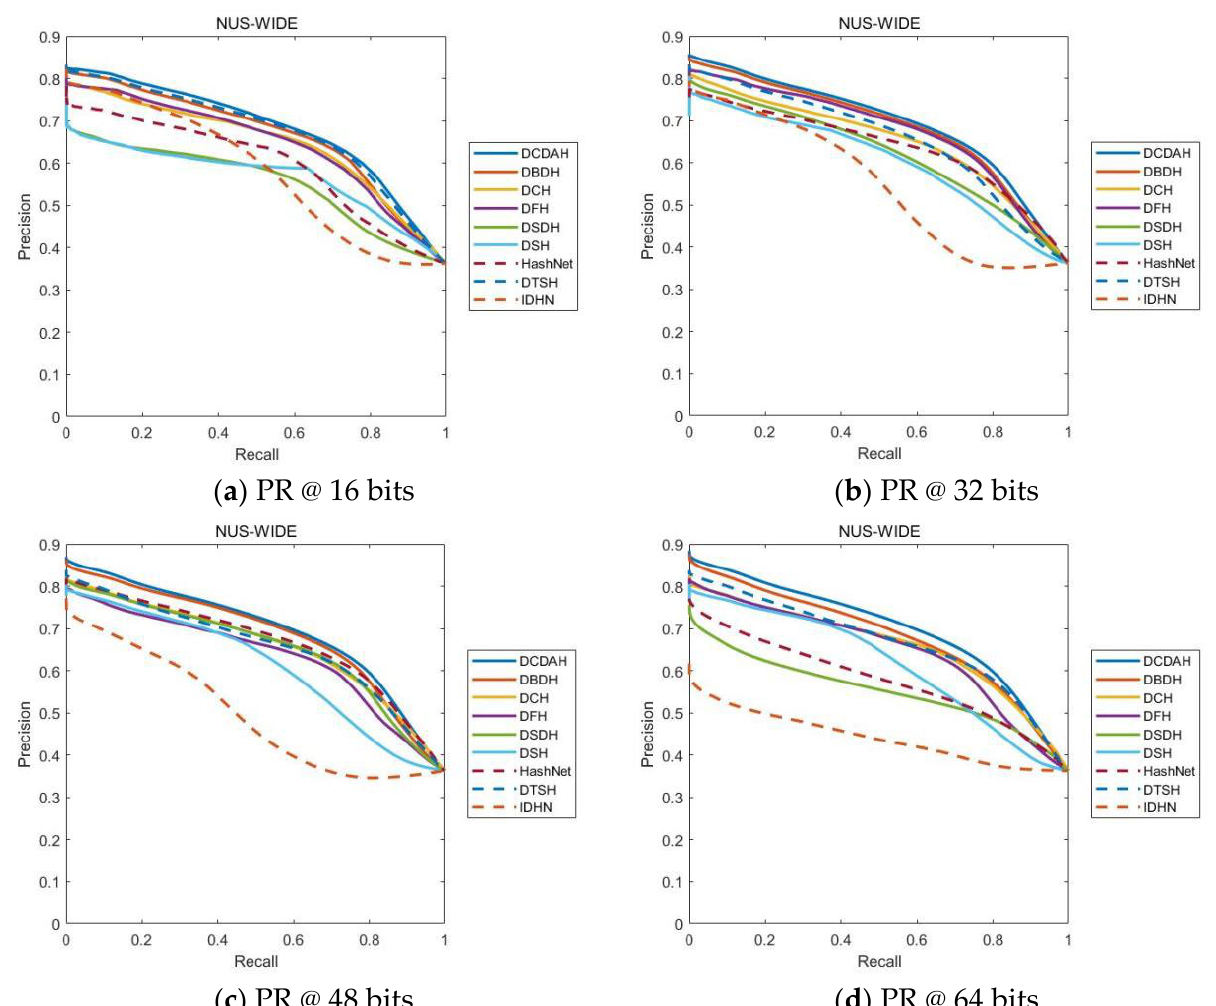
Figure 6. PR curves of all algorithms on NUS-WIDE when the hash code takes 4 different lengths.